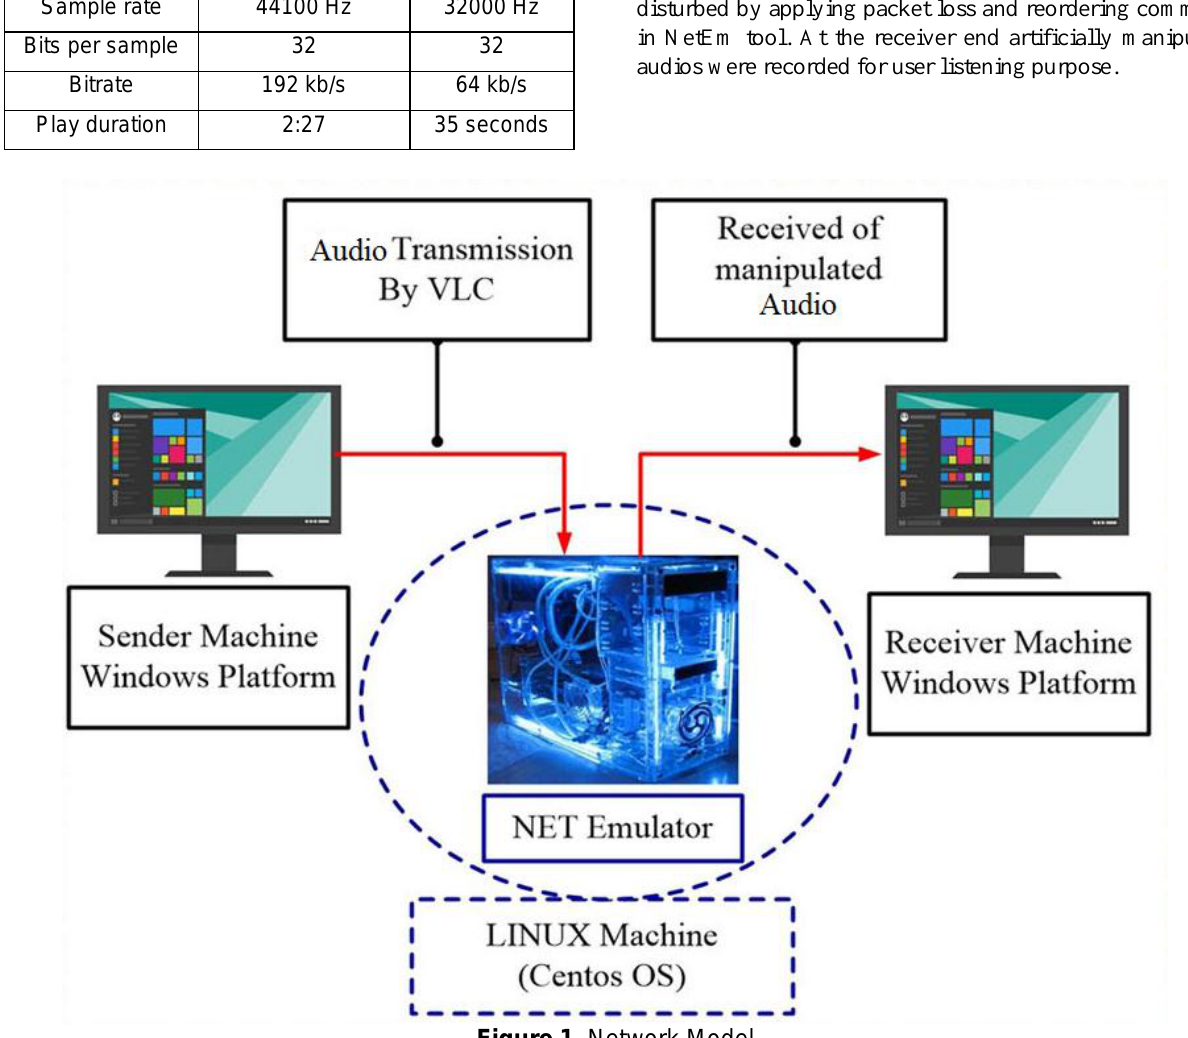
Table 1. Details of Audio